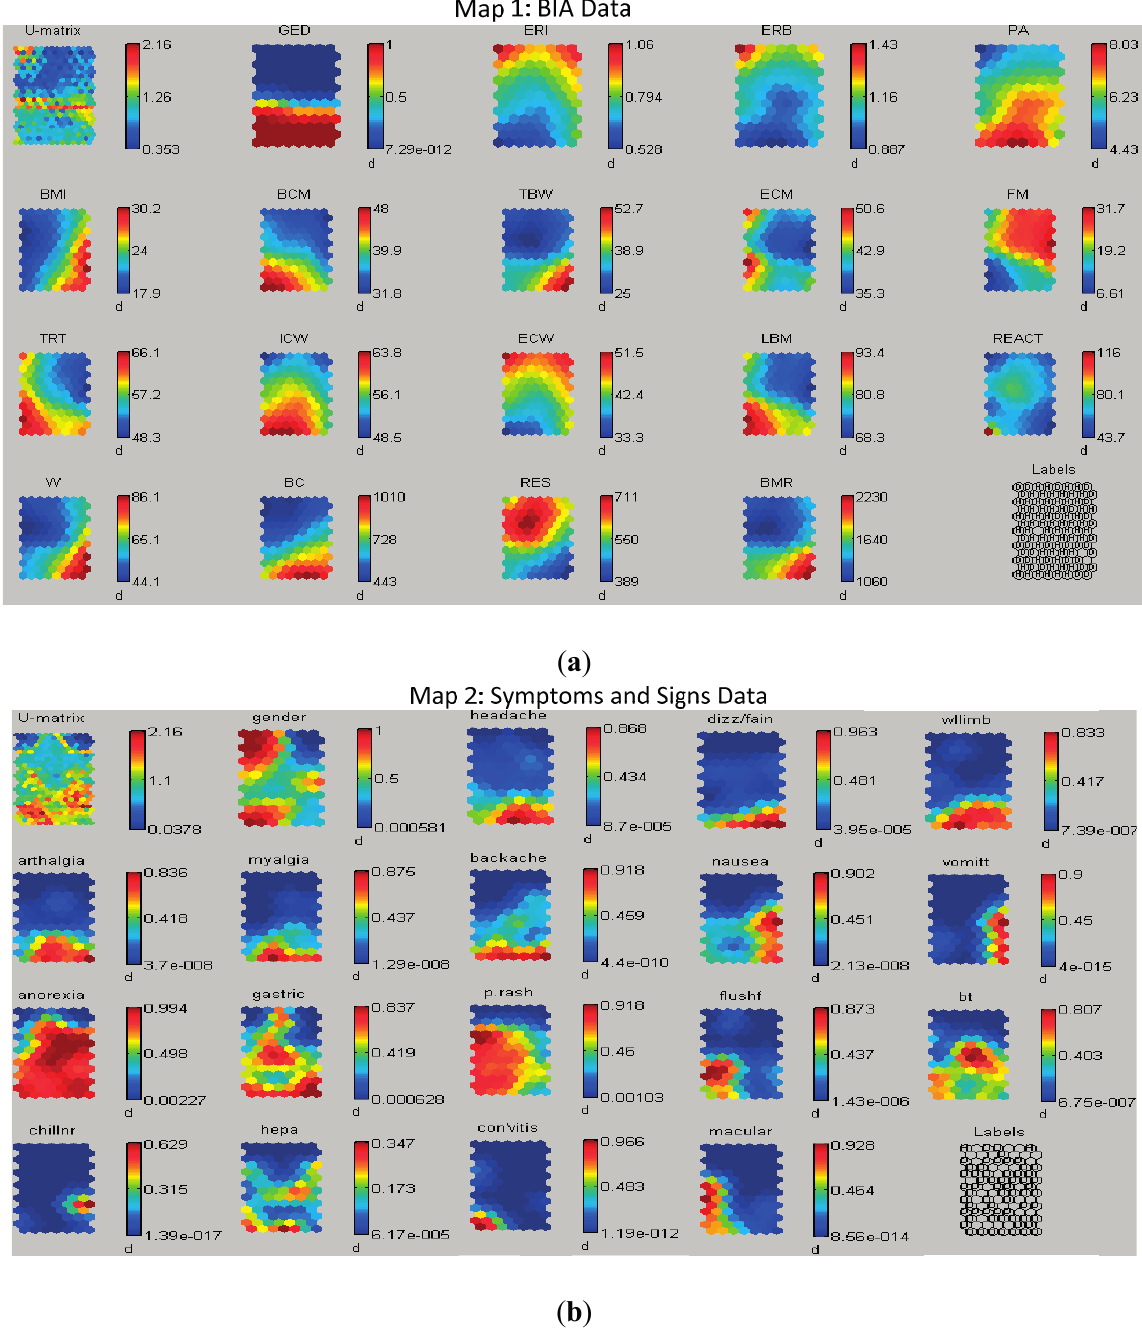
Figure 2. ( a ) Visualization of the self organizing maps for the bioelectric impedance analysis parameters; ( b ) Symptoms, and signs data. Reproduced with permission